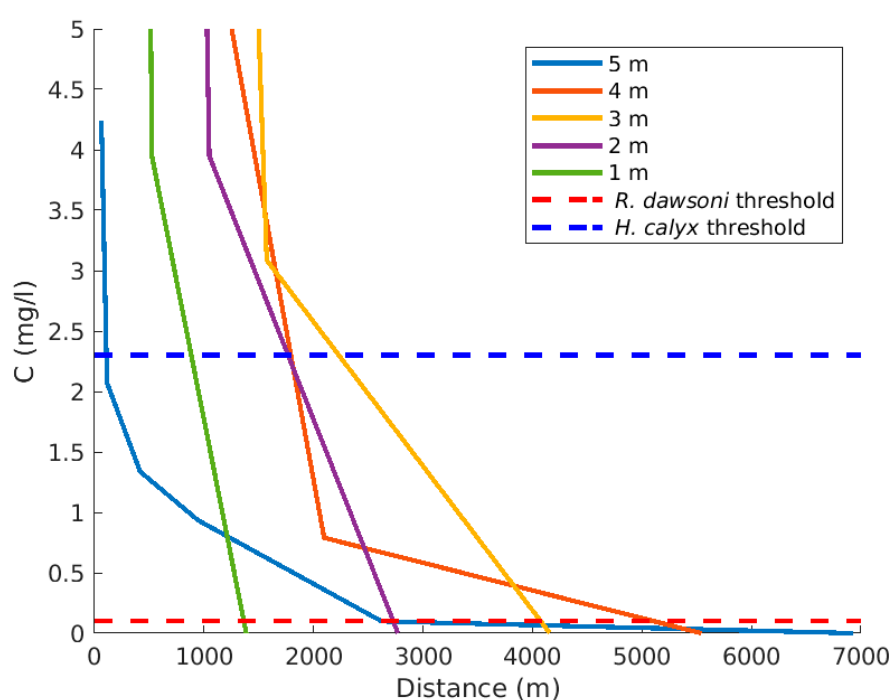
Figure 7. Change in concentration (C (mg/L)) of the sediment with distance under a representative maximum 4 h current of 0.35 m/s. Values are based on initial sediment concentrations of 550, 550, 430, 110, and 14 mg/L at 1, 2, 3, 4, and 5 m above seabed, respectively. The effective pumping arrest threshold concentrations of R. dawsoni and H. calyx for the fishing-induced sediment are also shown (dashed line).